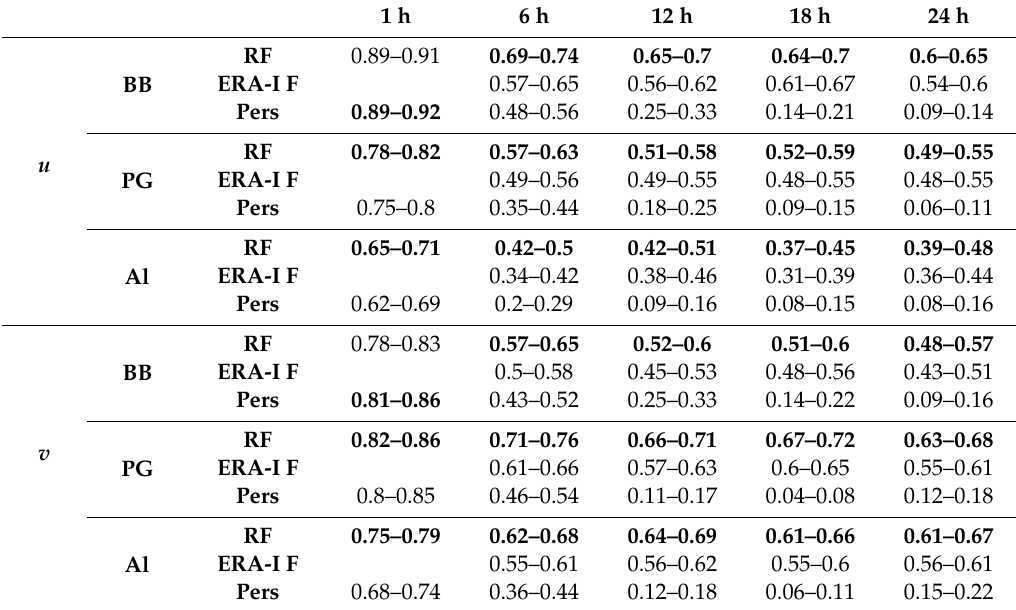
Table 5. R 2 index (95% confidence interval) of u and v wind components for the steps 1, 6, 12, 18, and 24 h, for three locations (Bilbao Bizkaia, Punta Galea, and Alegria), and RF, ERA-Interim forecasts, and persistence models. Highest values of R 2 are highlighted by means of bold font.